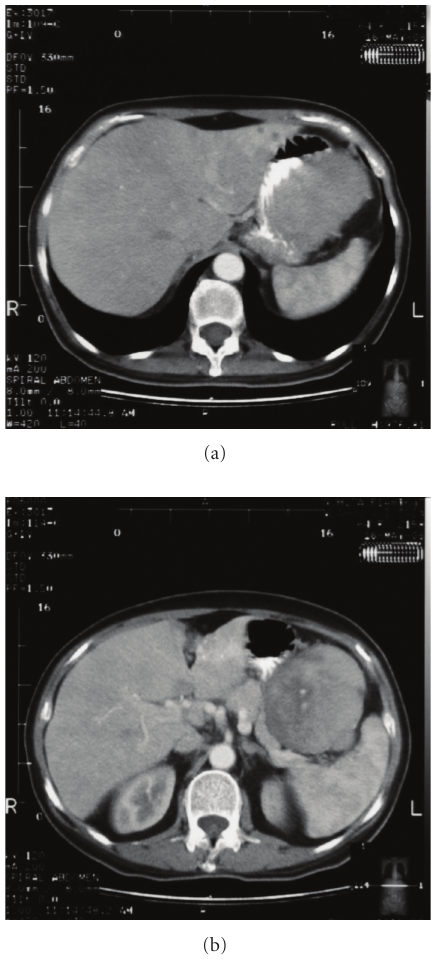
Figure 1: A contrast enhanced abdominal CT scan shows a large, 13.5 × 7.7 × 8.5 cm, heterogeneously enhanced mass. The mass appeared to adhere to the stomach (a). There is a clear plane between the mass and the adjacent spleen and pancreas (b).